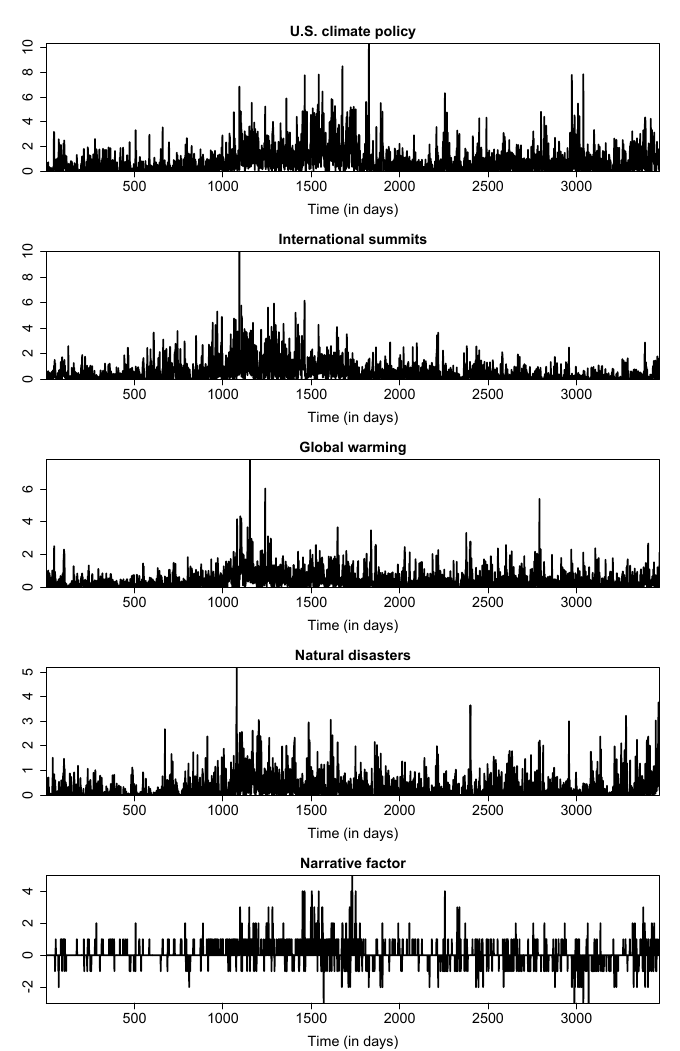
Figure 3. Climate risks. The sample period is 3 January 2001–27 November